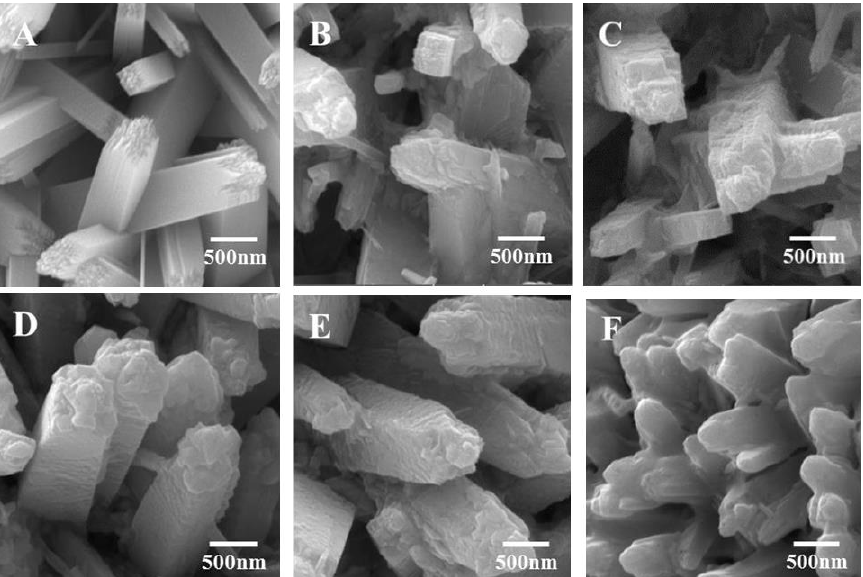
Figure 2. SEM images of WO 3 /TiO 2 /CC prepared by different cathodic current densities ( A ) 0; ( B ) − 8 mA/cm 2 ; ( C ) − 10 mA/cm 2 ; ( D ) − 12 mA/cm 2 ; ( E ) − 14 mA/cm 2 ; ( F ) − 16 mA/cm 2